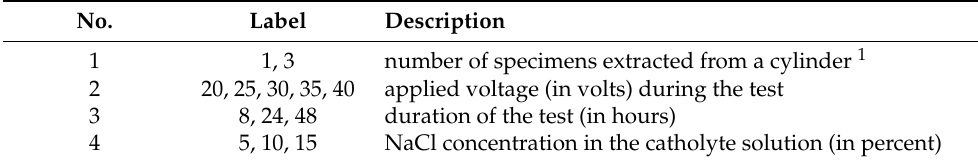
Table 3. Labelling of the test modifications.